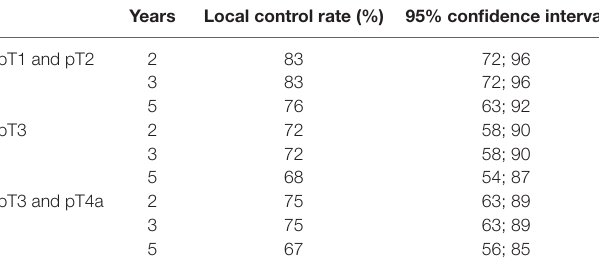
Table 4 | Kaplan–Meier estimates of local control.